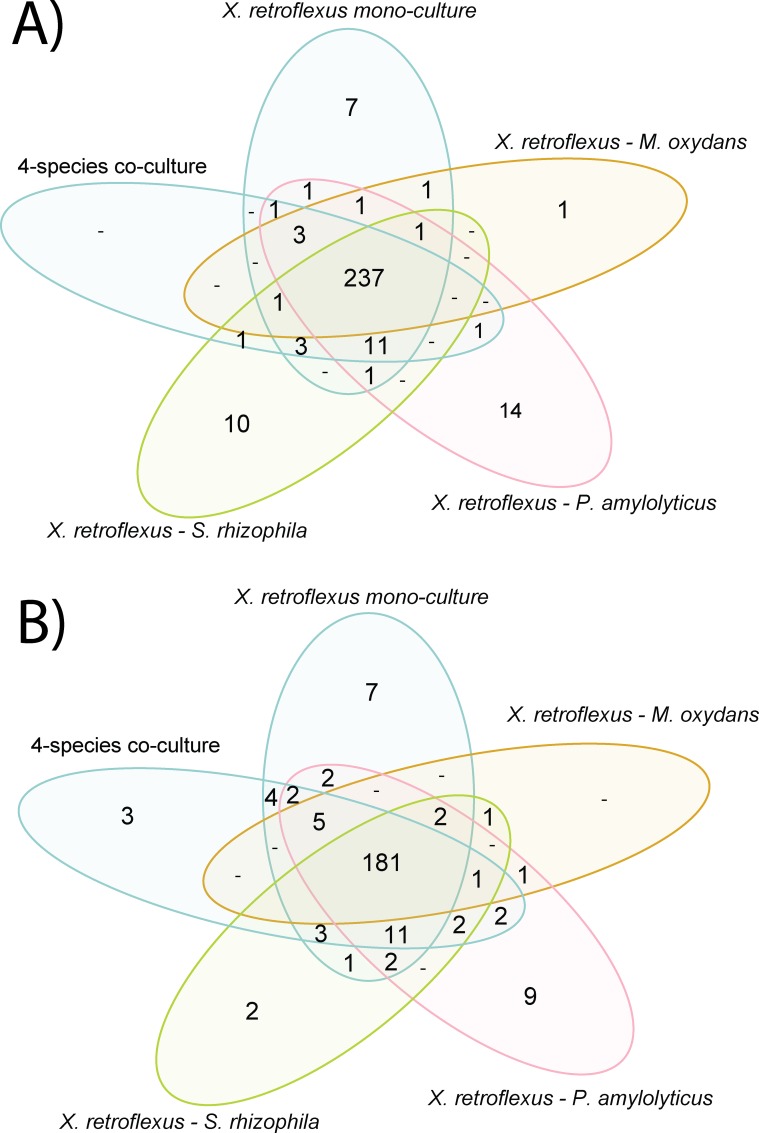
Number of identified and quantifiable proteins from the secretome LC-MS/MS analysis.Identified proteins from the secretome samples were filtered by; i) removing the two outlying biological replicates and ii) removing proteins which did not contain a signal peptide. A) Identified proteins and their overlap between different sample groups, only requiring that the protein is observed in one sample of all biological replicates. B) Quantifiable proteins are defined as proteins which were detectable in 4 out of the 6 biological replicates of a given culture. From each co-culture type, only proteins shared with the X. retroflexus mono-culture were included in the differential abundance analysis.